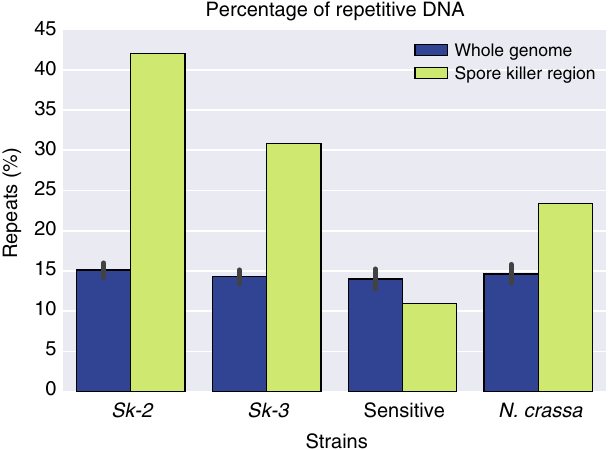
Fig. 2 Percentage of repetitive DNA in three strains of Neurospora intermedia with different spore killer phenotypes (Sk-3: 3194; Sk-2: 7426; sensitive: 8761). Blue bars show the whole genome, and yellow bars the non- recombining spore killer region. Error bars (95% con fi dence intervals) for the whole-genome data were calculated using sliding windows of the same size as the spore killer region, with a step size of 200 kb. Note that no formal statistical test has been performed to determine if the repeat content in the spore killer region is signi fi cantly different from the background genome, but the data point does not overlap with the 95% con fi dence interval from the whole